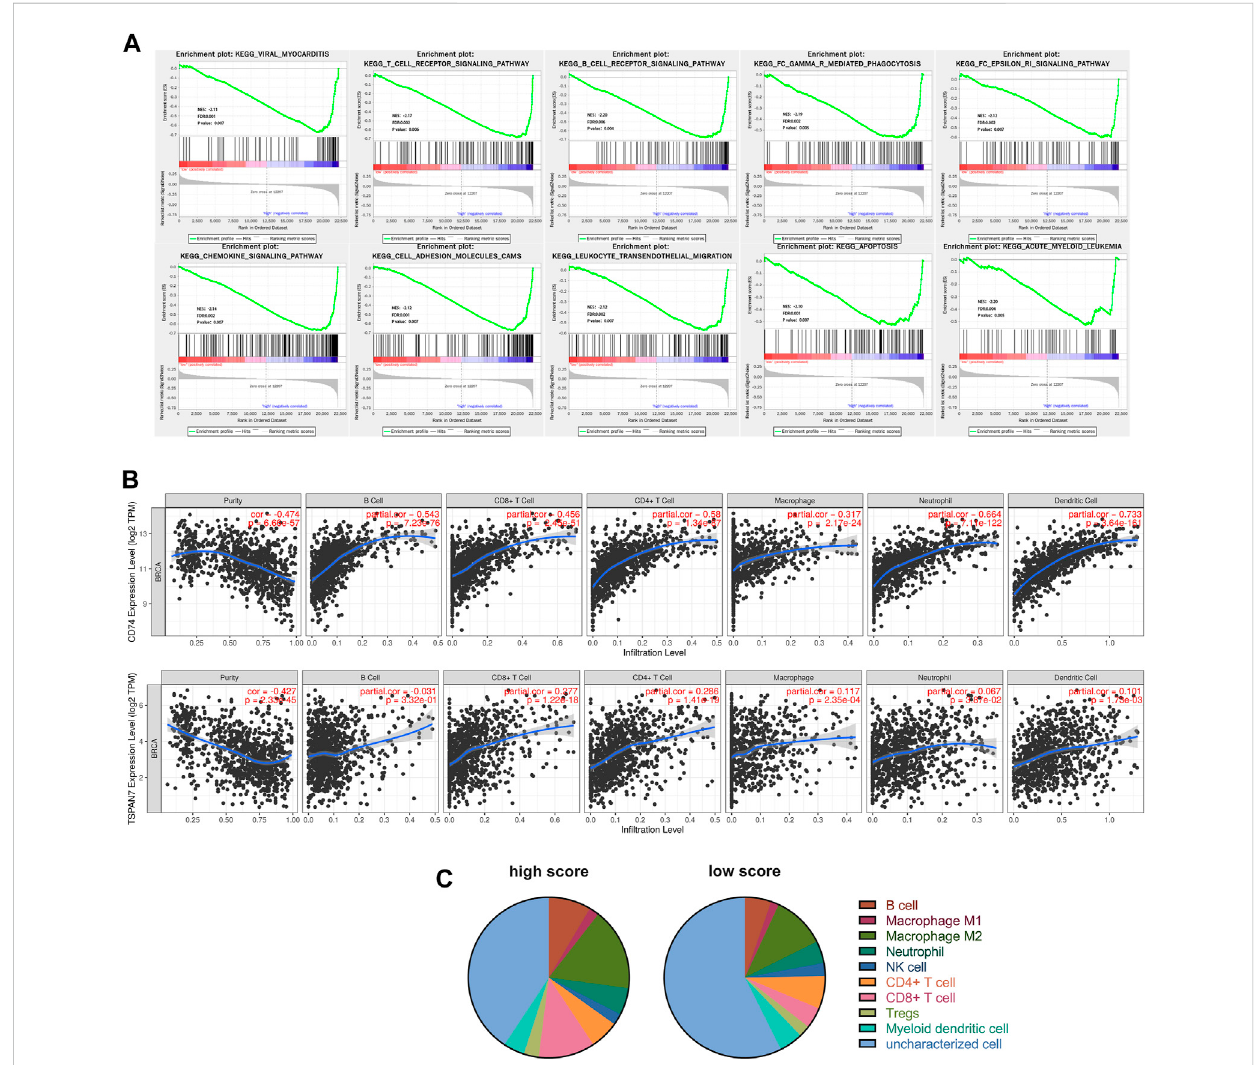
FIGURE 7 Functional analysis of the CD74 and TSPAN7. (A) GSEA identi fi ed gene sets signi fi cantly enriched in the phenotype of high score patients based on the IIRS. (B) Correlations between CD74 or TSPAN7 expression and immune in fi ltration levels. (C) Different levels of immune in fi ltration were observed between the high score ( n = 212) and the low score ( n = 202)